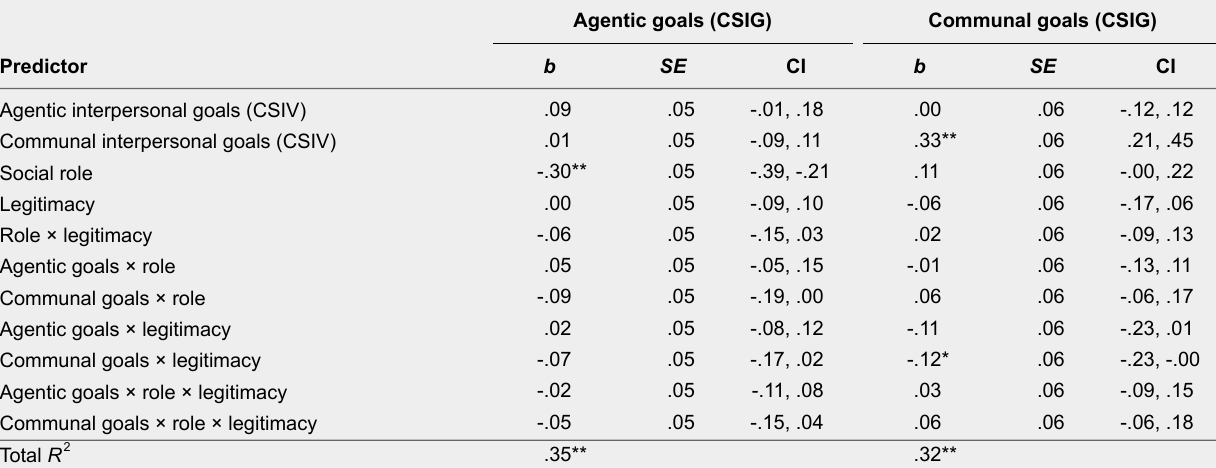
Multiple Regression Analyses Predicting Agentic and Communal Interaction Goals From Agentic and Communal Interpersonal Goals, Social Role, and Legitimacy of Group Inequality (Study